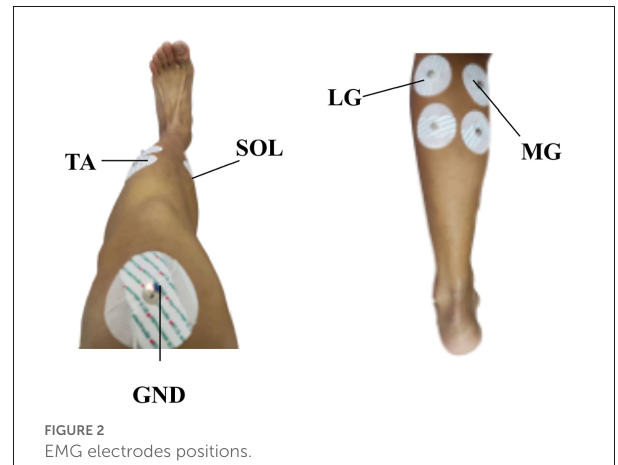
FIGURE2 EMG electrodes positions.